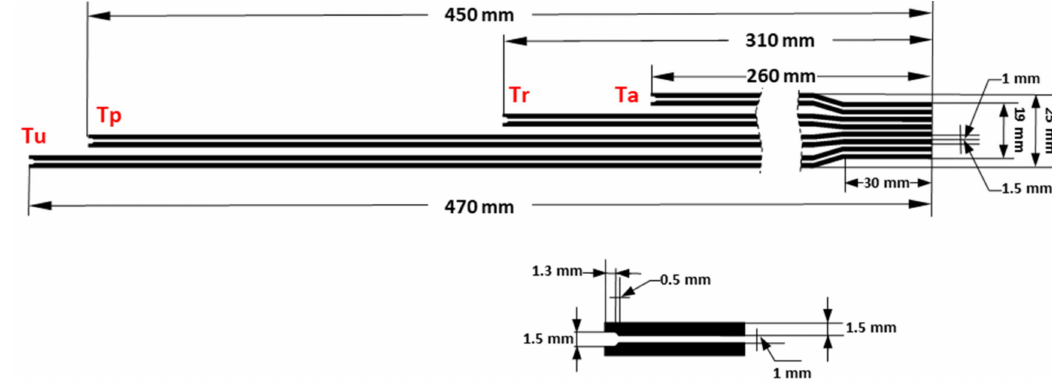
Figure 2. Multisensor dimensions. The top of the figure shows the overall dimensions, and the dimensions of the temperature sensor zone are shown at the